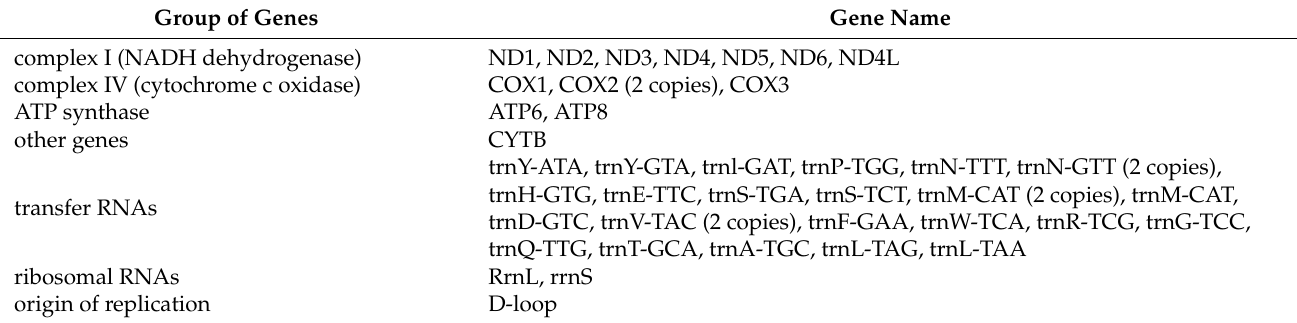
Table 3. Gene content of the Ruditapes philippinarum genome.